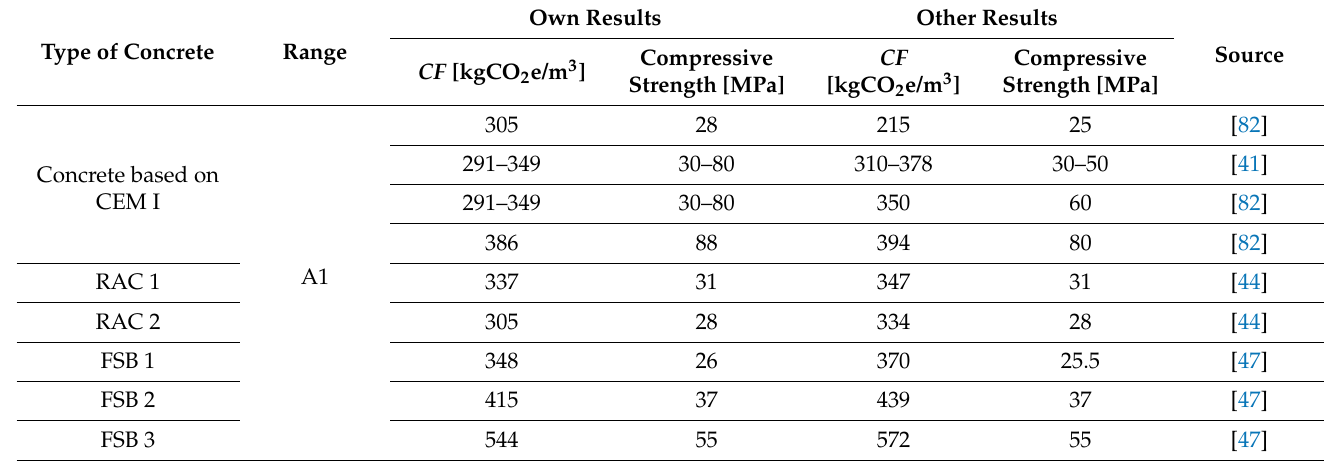
Table 8. Comparison of results with other studies.